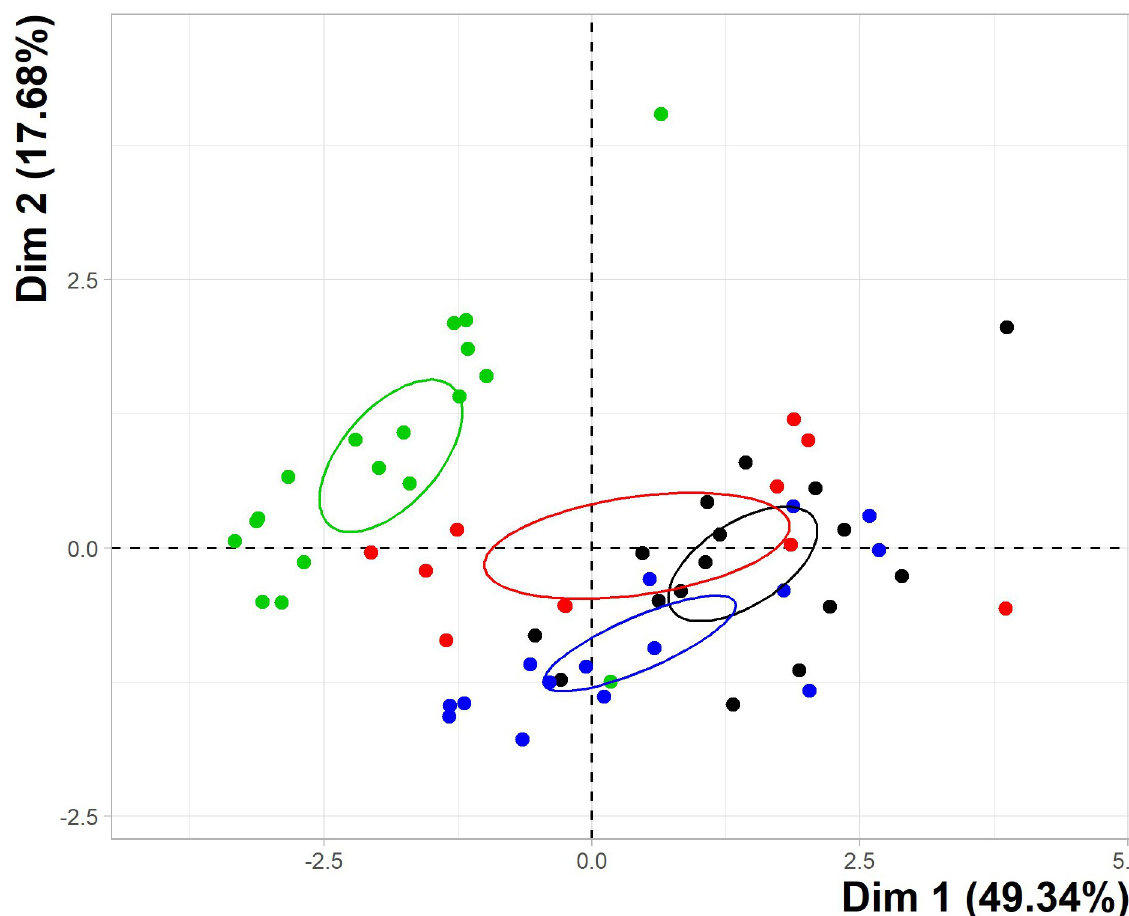
Fig 3. PCA individual plot. Depiction of all seagrass metal data reduced to two principal dimensions (Dim 1 and 2). Each point indicates an individual seagrass sample and data are categorised by location, represented as different colours (Howick Island Group, HWK = green, Cockle Bay, CB = black, Upstart Bay, UB = blue and Edgecumbe Bay, EB = red). Confidence ellipses are colour coordinated with the individual sample points. Dimension 1 (Dim 1) represents 49.34% of total variations and Dim 2 represents 17.68%. HWK data provided by Thomas et al [5].